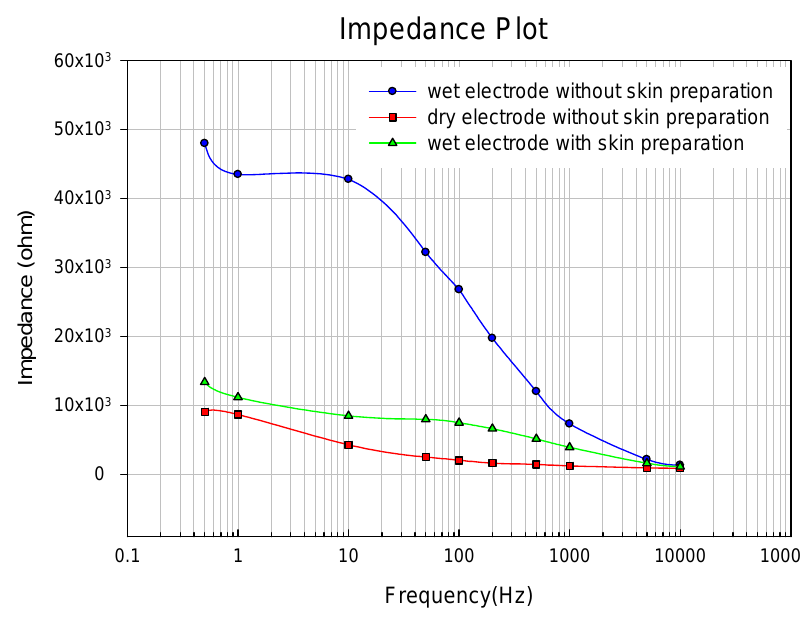
Figure 4. Electrode-skin interface impedance measurement result. Impedance